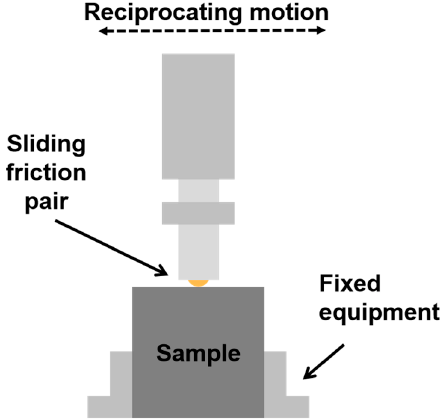
Figure 4. Schematic diagram of friction test. Table 5. The parameters for dry sliding friction and wear test.